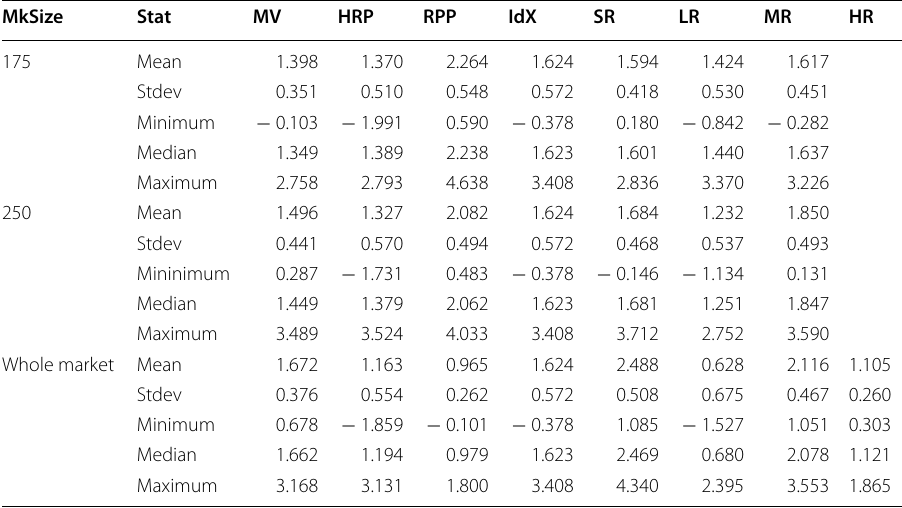
Table 8 Annualized sharpe ratio ( SR ann ) of the simulations (1500 random investing paths) for the different strategies